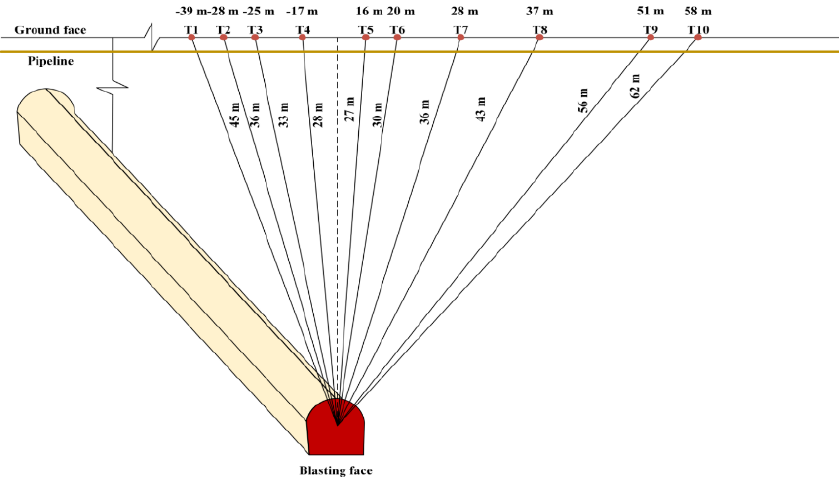
Figure 4. Monitoring locations.